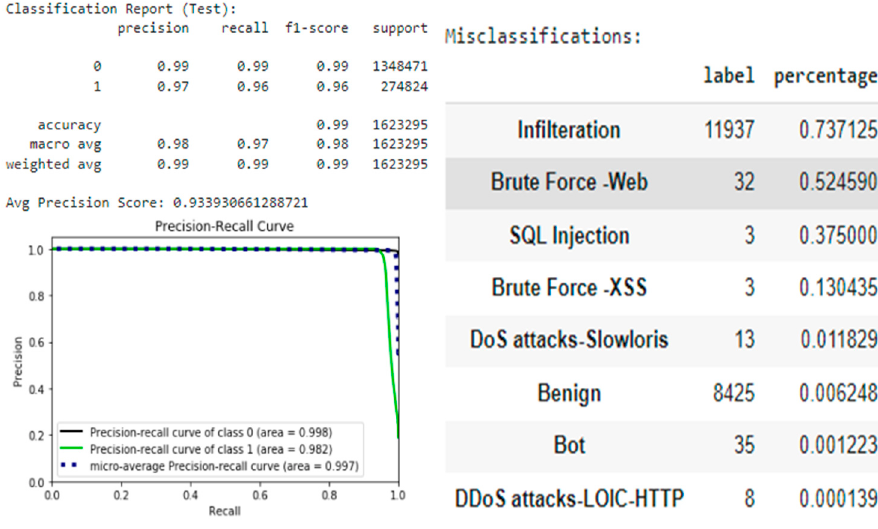
Figure 7. Gradient Boost performance on test dataset.